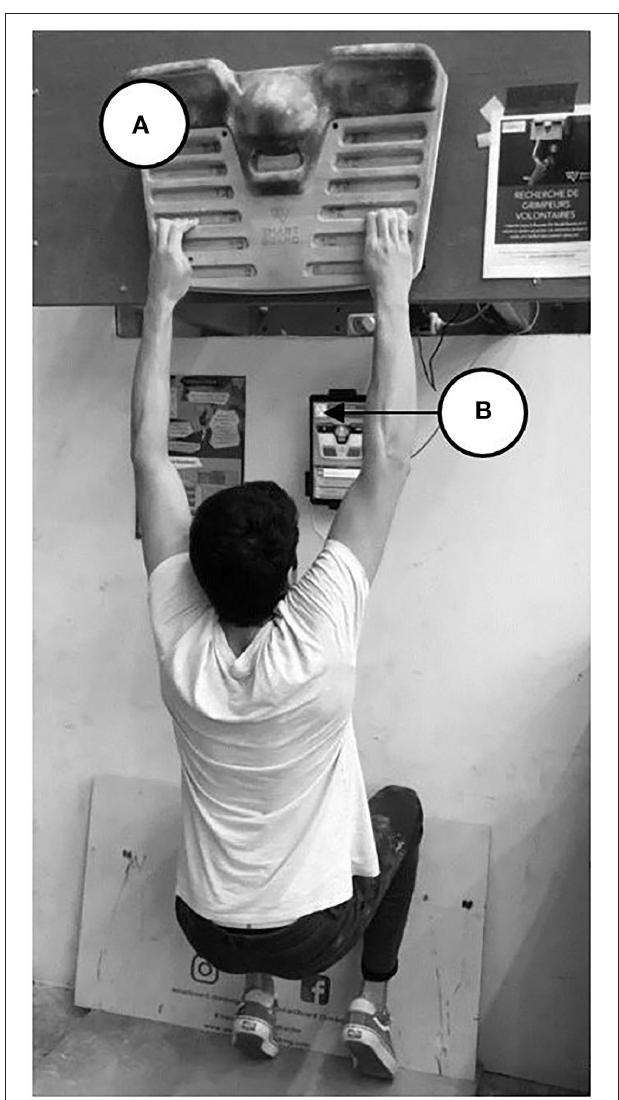
FIGURE 1 | Force-time curve during the 24 repetitions of the fatigue test of one representative participant. Stamina (represented by the horizontal arrow) is the capacity to maintain the 80% of maximal finger strength (MFS) threshold. Endurance is the percentage of force the participant is able to perform after the onset of fatigue (represented by the dotted black line). On this test, the participant performed 633N for MFS, 45.2% for stamina and 70.3% for endurance .